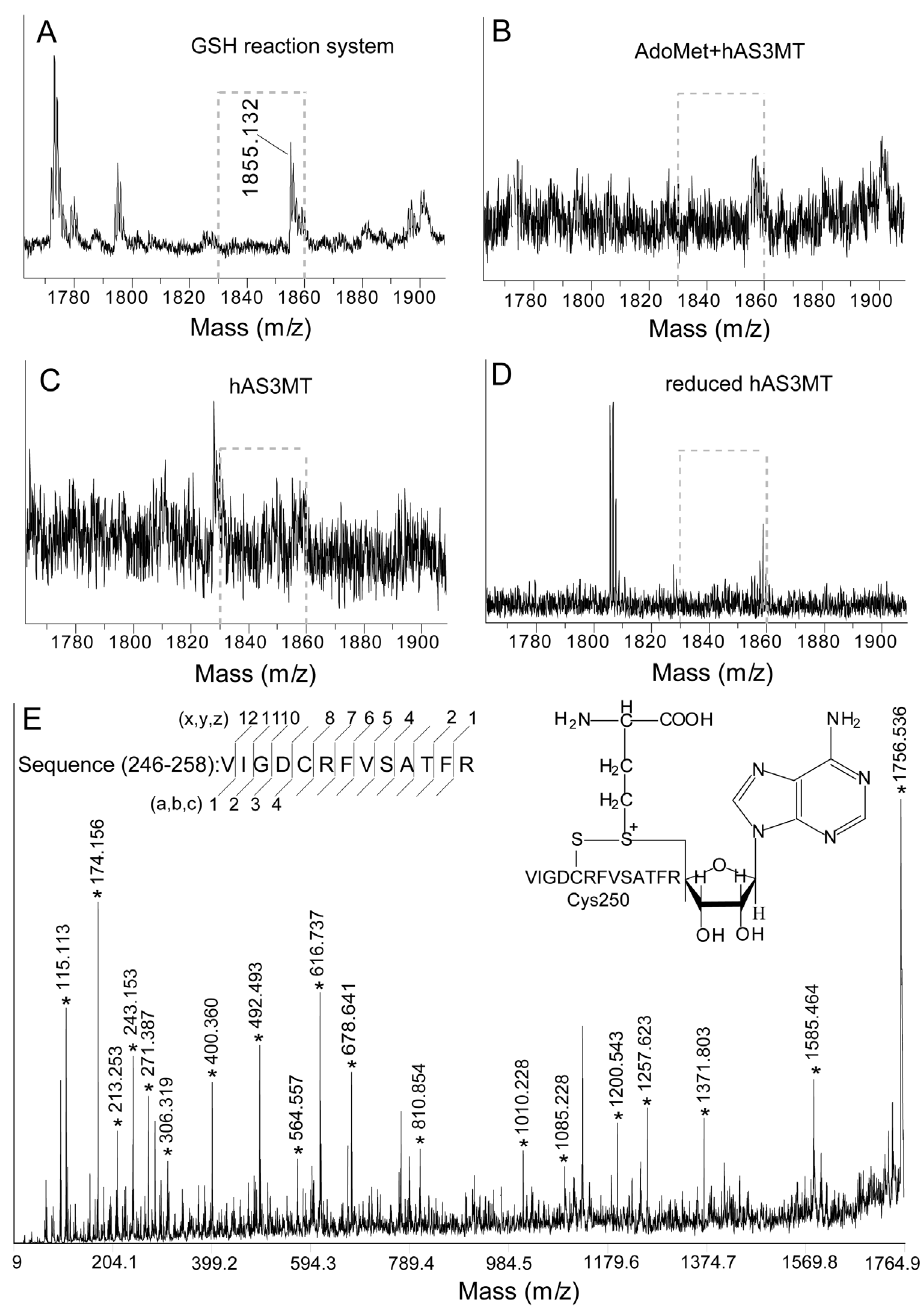
Figure 5. The intermediate of Cys250-AdoHcy analyzed by MALDI-TOF-MS. (A) in GSH reaction system. (B) in AdoMet control. (C) in hAS3MT. (D) in reduced hAS3MT. (E) MS/MS spectra for the sequence at 1855.13 (m/z) of hAS3MT in GSH reaction system. Labels a, b, c, x, y, and z represent the cleavage manners of peptide. AdoMet control: 1.0 mM AdoMet was incubated with 2.0 m M hAS3MT at 37 u C for 60 min.